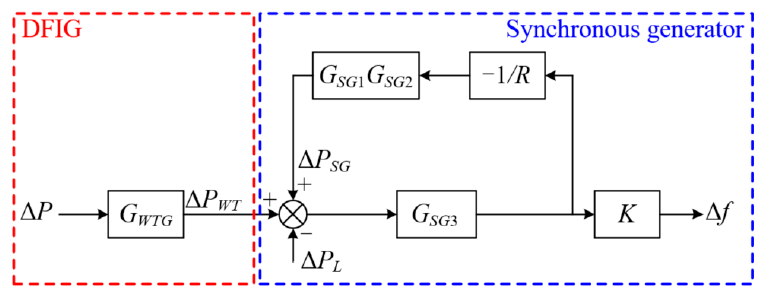
Figure 6. Simplified diagram of a DFIG and a synchronous generator for the local stability analysis.